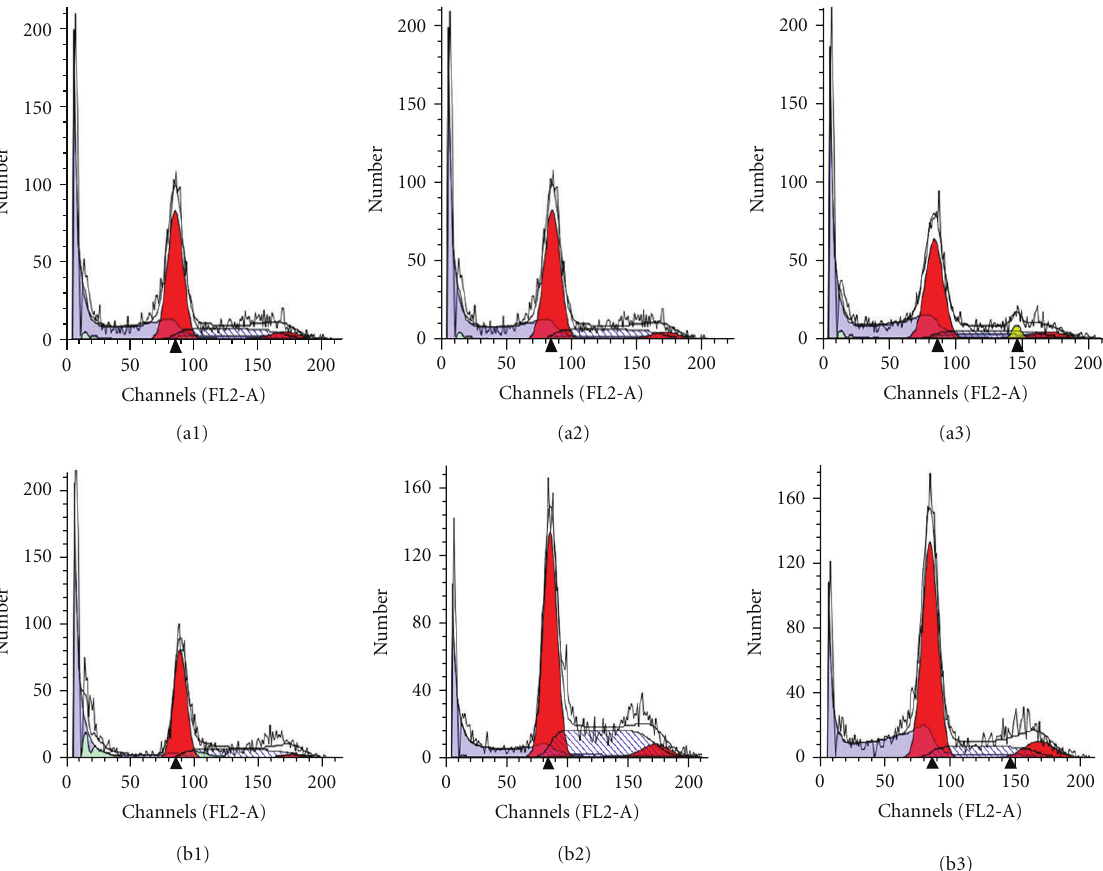
Figure 5: The distribution of cell cycle under normoxia and hypoxia. (a1)–(a3): The distribution of cell cycle in control group, radiotherapy- alone group and Endostar + radiotherapy group under normaxia. (b1)–(b3): The distribution of cell cycle in control group, radiotherapy- alone group and Endostar + radiotherapy group under